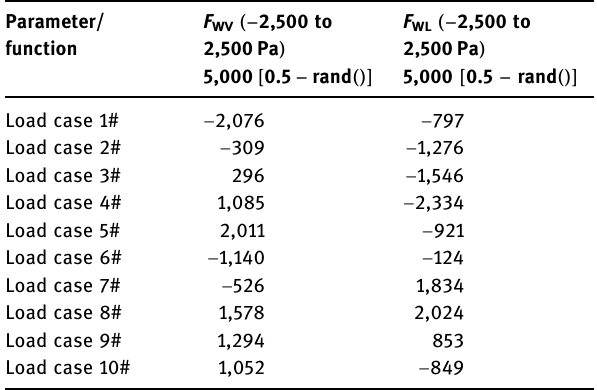
Table 3: Load cases in simulation validation by random method